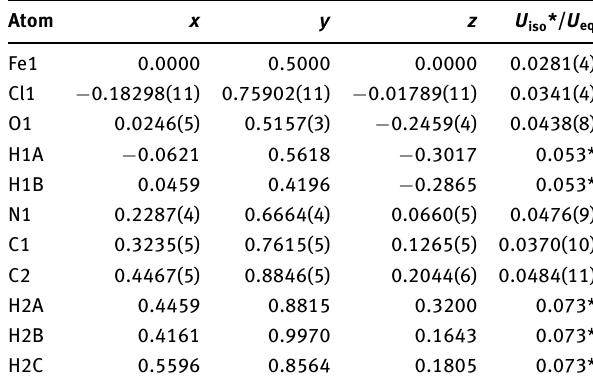
Table 2: Fractional atomic coordinates and isotropic or